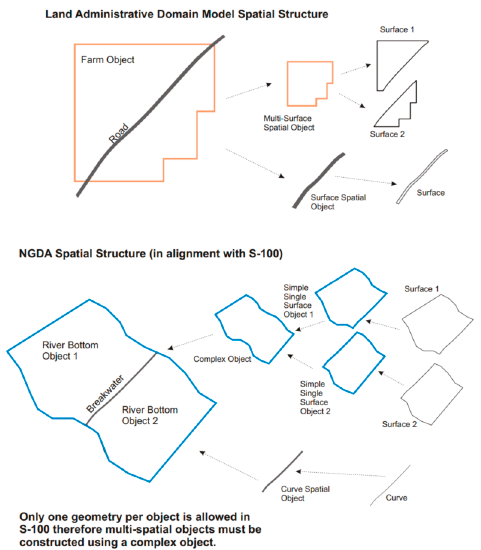
Figure 3. Terrestrial and maritime spatial structures according to LADM and S-100 [18].